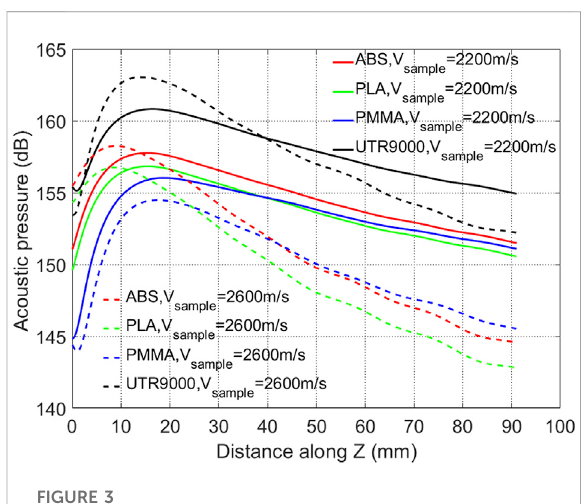
FIGURE 3 Simulated pressure with the selected bricks along Z at X = 0 for different manufacturing